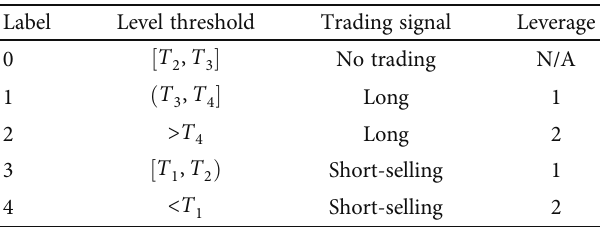
Figure 2: The design of multiclassi fi cation and trading simulation of the proposed method. Table 4: The design of label, threshold, trading signal, and leverage of the trading strategy for the proposed method.